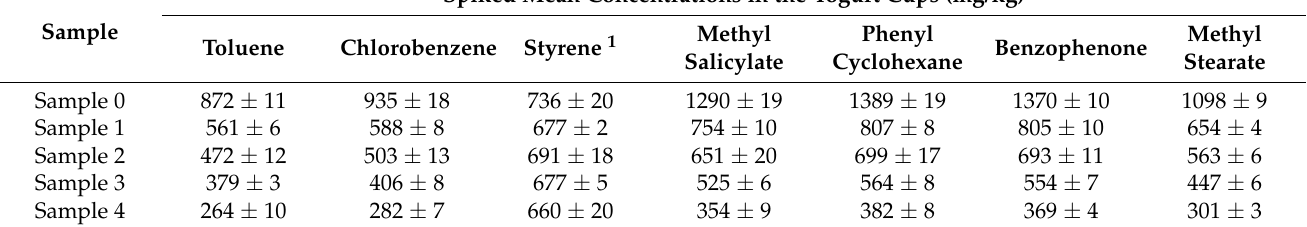
Table 1. Experimentally determined mean concentrations of spiked surrogates and styrene in the investigated yogurt